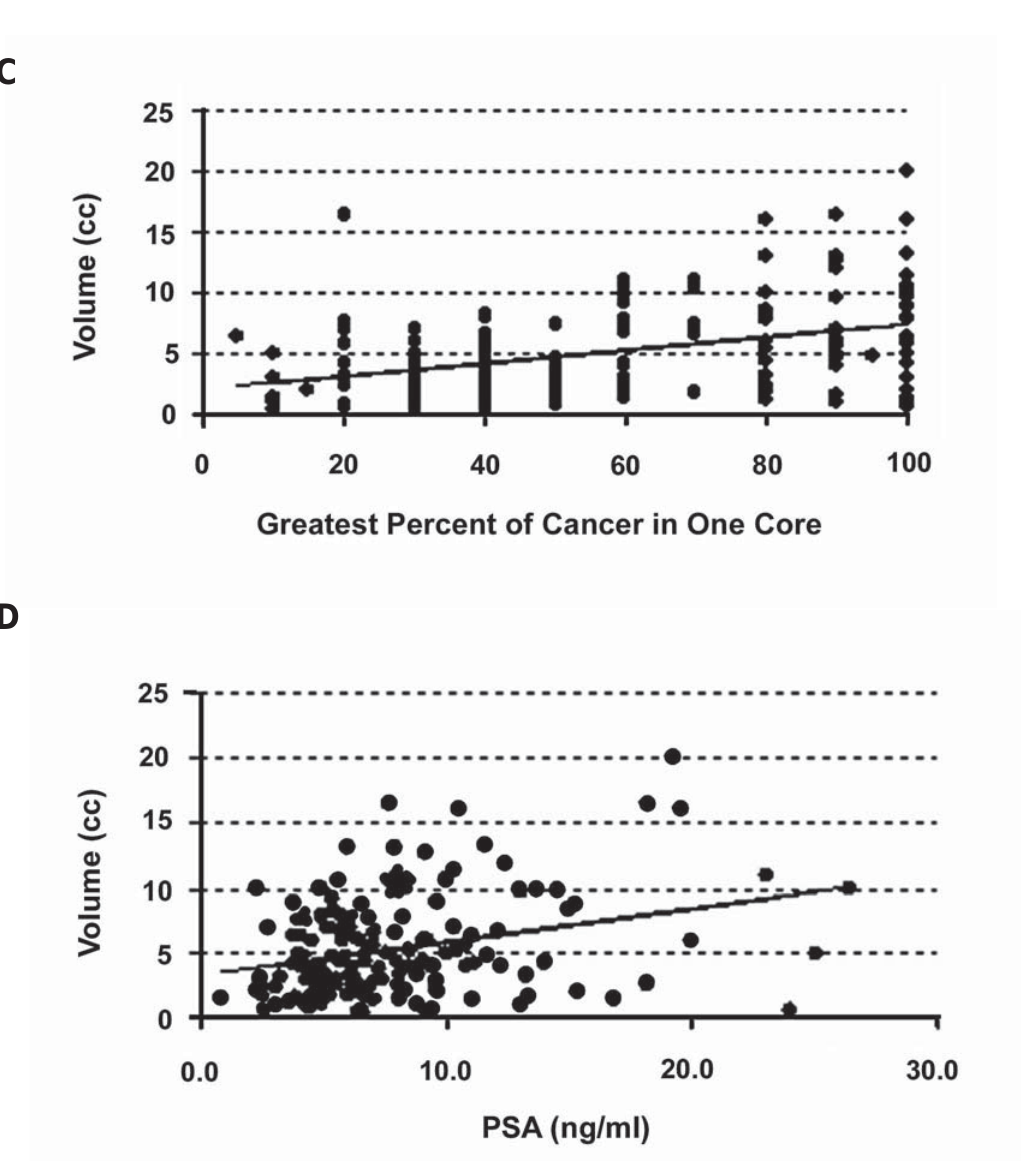
Figure 2 – C) Tumor volume scatter plot according to the maximum percentage of cancer in a fragment (r = 41.4% - 95% IC [27.6% - 53.6%]). D) Tumor volume scatter plot according to the prostate specific antigen (r = 30.7% - 95% IC [16.0% -